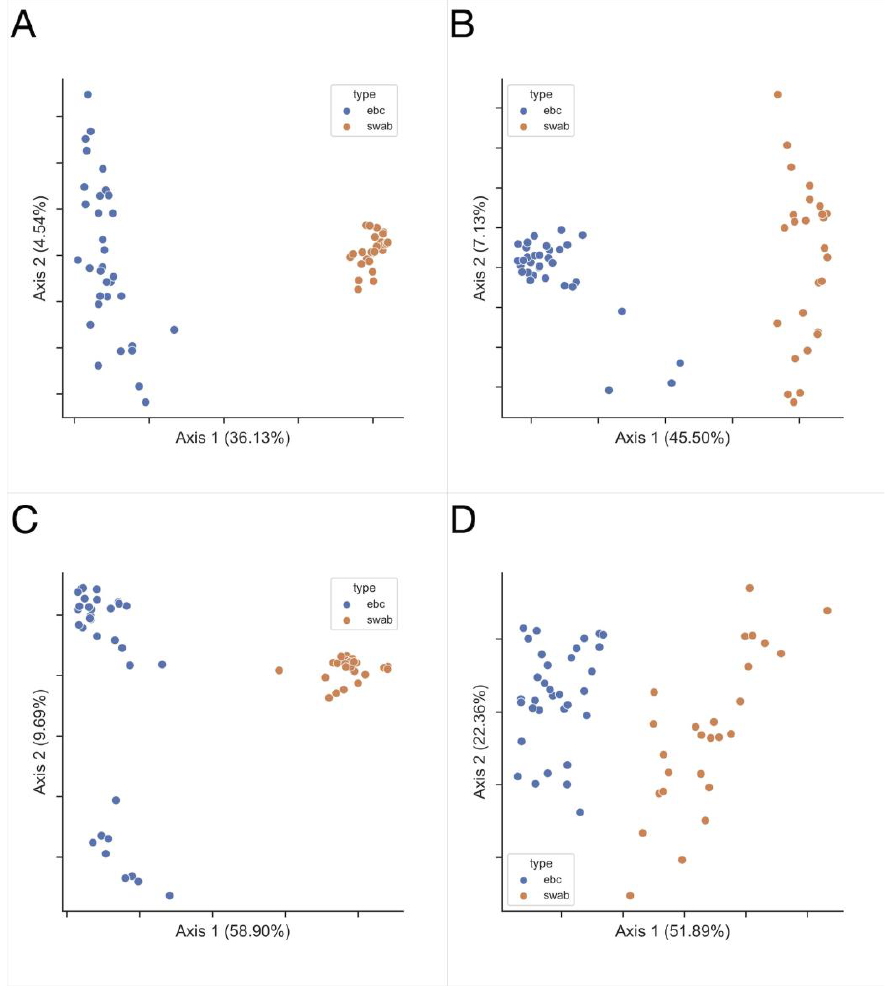
Figure 2. The microbiota of lower airways (EBC samples in blue, n = 33) differs from the microbiota of upper airways (swab samples, in orange, n = 26) asthma and control group taken together, as principal coordinate analysis (PCoA) plots capture the beta diversity for ( A ) Jaccard, ( B ) Bray-Curtis, ( C ) Unweighted UniFrac, and ( D ) Weighted UniFrac metrics, in all cases p = 0.001, PERMANOVA test, 999 permutations.